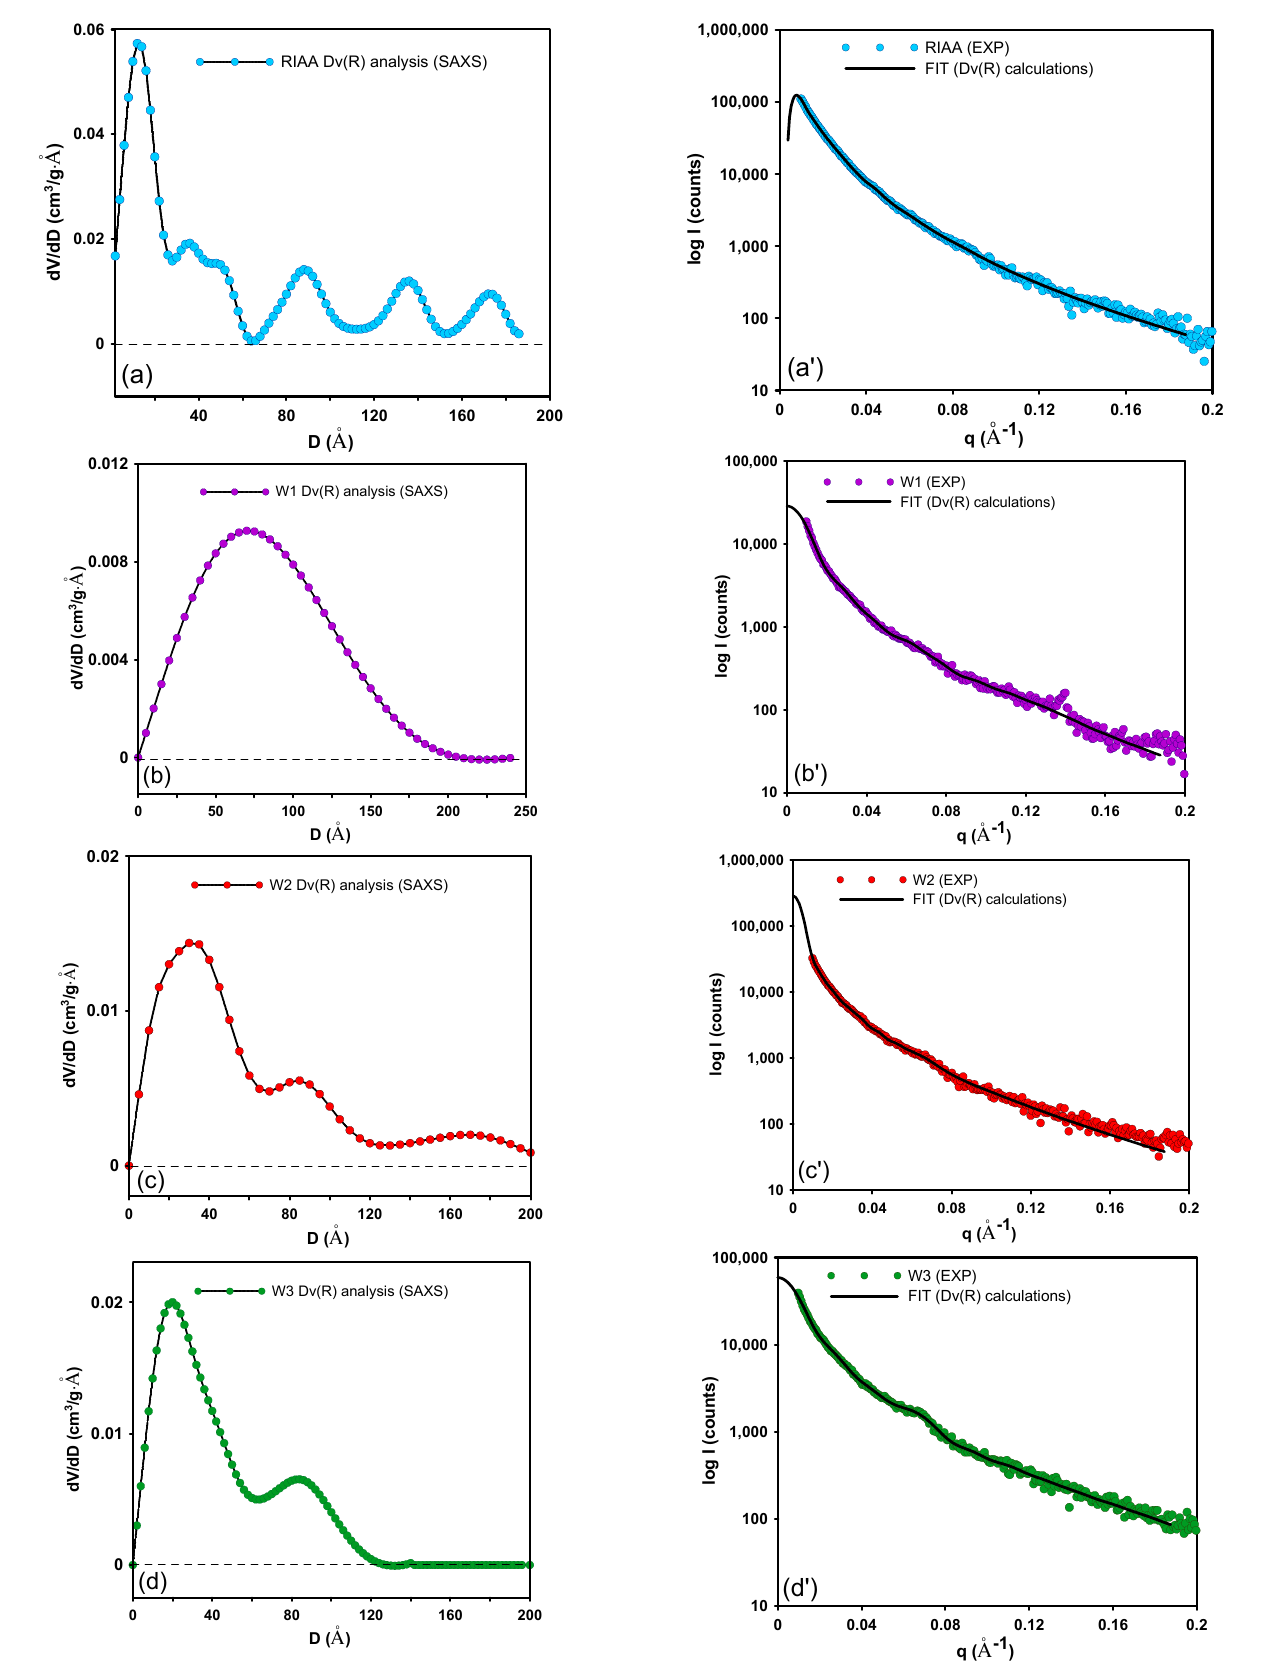
Figure 3. Pore size distribution by the volume analysis Dv(R) for the investigated systems ( a − d ). The insets of plots correspond to the fit curves extrapolated for the experimental data ( a’ − d’ ).